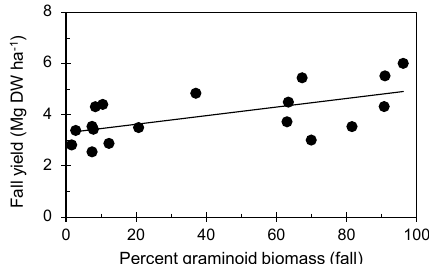
Figure 2. The relationship between the percent of fall graminoid biomass and fall prairie yield combined among 2009, 2010, and 2011. The effect of percent graminoid biomass was significant ( p = 0.020), but the effect of year was not significant. Full model R 2 was 0.37.